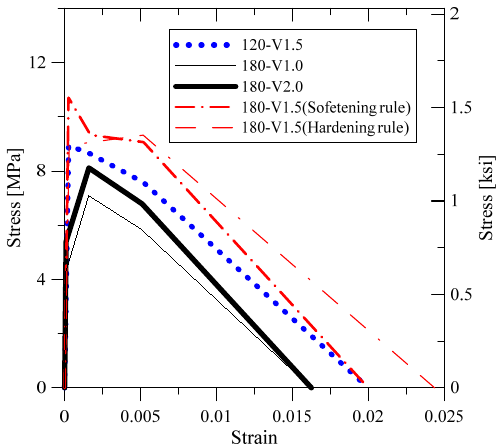
Figure 10. Tensile stress-strain relation of tested matrix.